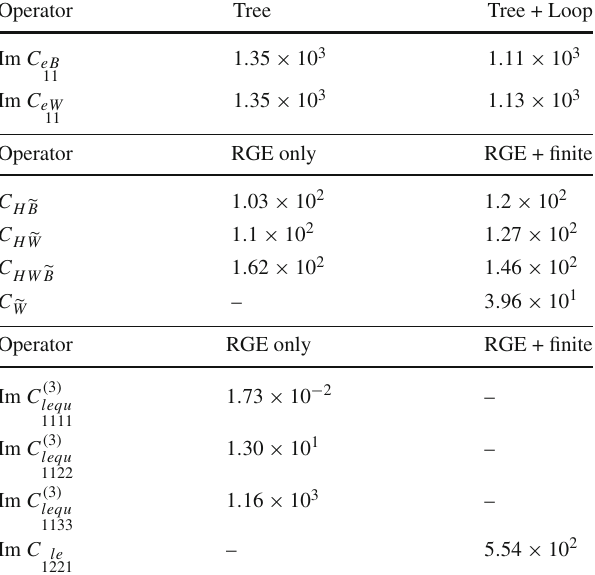
Table 5 Lower bounds on the UV scale (cid:2) in TeV assuming the natural scaling for all Wilson coefficients as given in the previous table and no further assumptions. The labeling of the tables is the same as for the bounds on the Wilson coefficients